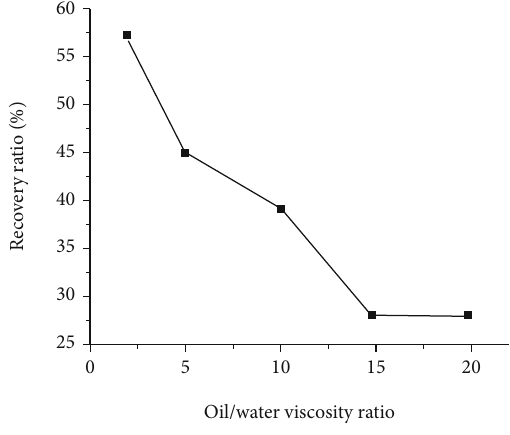
Figure 9: Recovery e ffi ciency versus oil-to-water viscosity